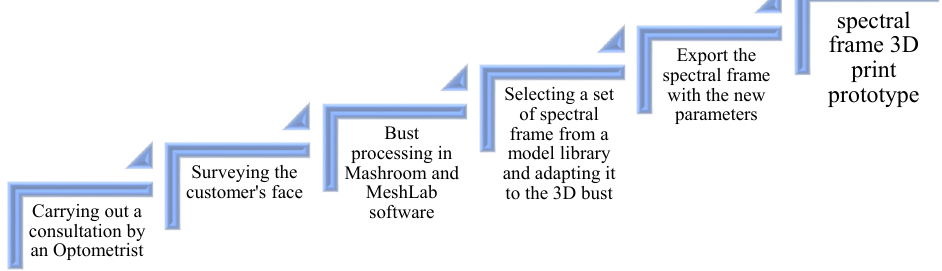
Figure 9. Schematic of the process of making 3D spectral spectacles frames.